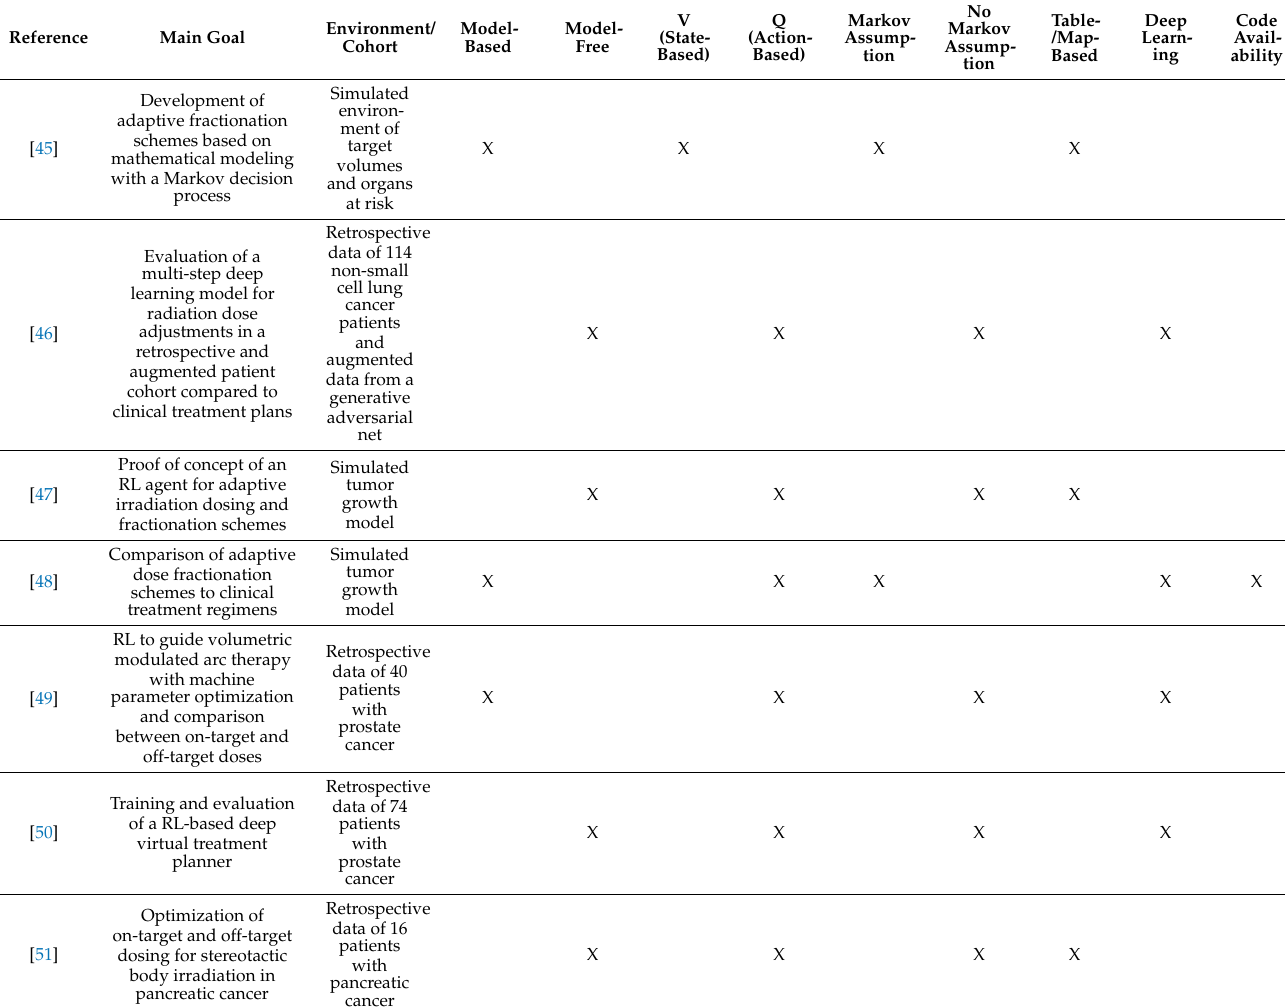
Table 4. Recent studies of reinforcement learning (RL) for adaptive dosing and fractionation of radiotherapy in cancer. Reference Main Goal